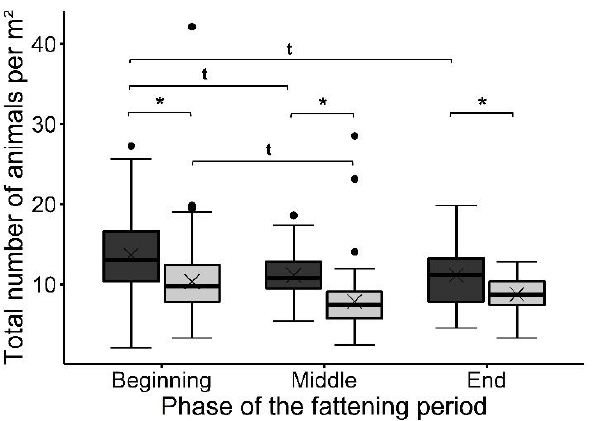
Figure 2. The total number of animals per m² in the observed area at the different phases of the fattening period ( n = three trials each). Results are presented as boxplots (data range, median, and lower and upper quartile; outliers are included in the graph as dots and means as a cross). Results of the experimental group (Exp) are presented in dark gray; the control group (Con) results are presented in light gray. * Significant difference at p < 0.05, t tendency at p < 0.1.